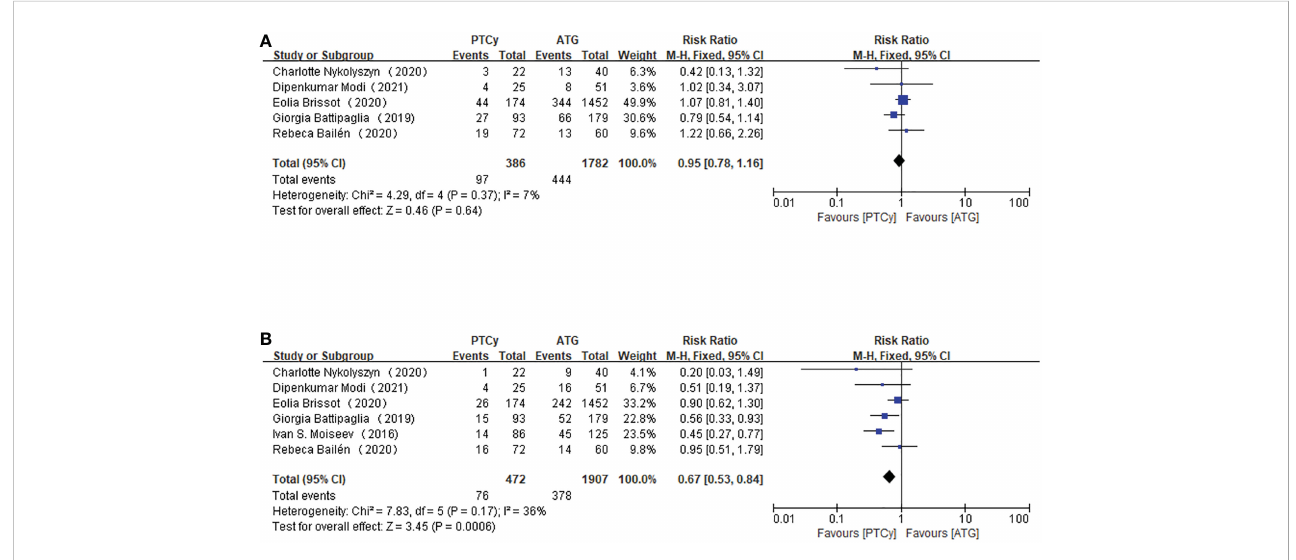
FIGURE 6 Forest plot of RI (A) and NRM (B) .